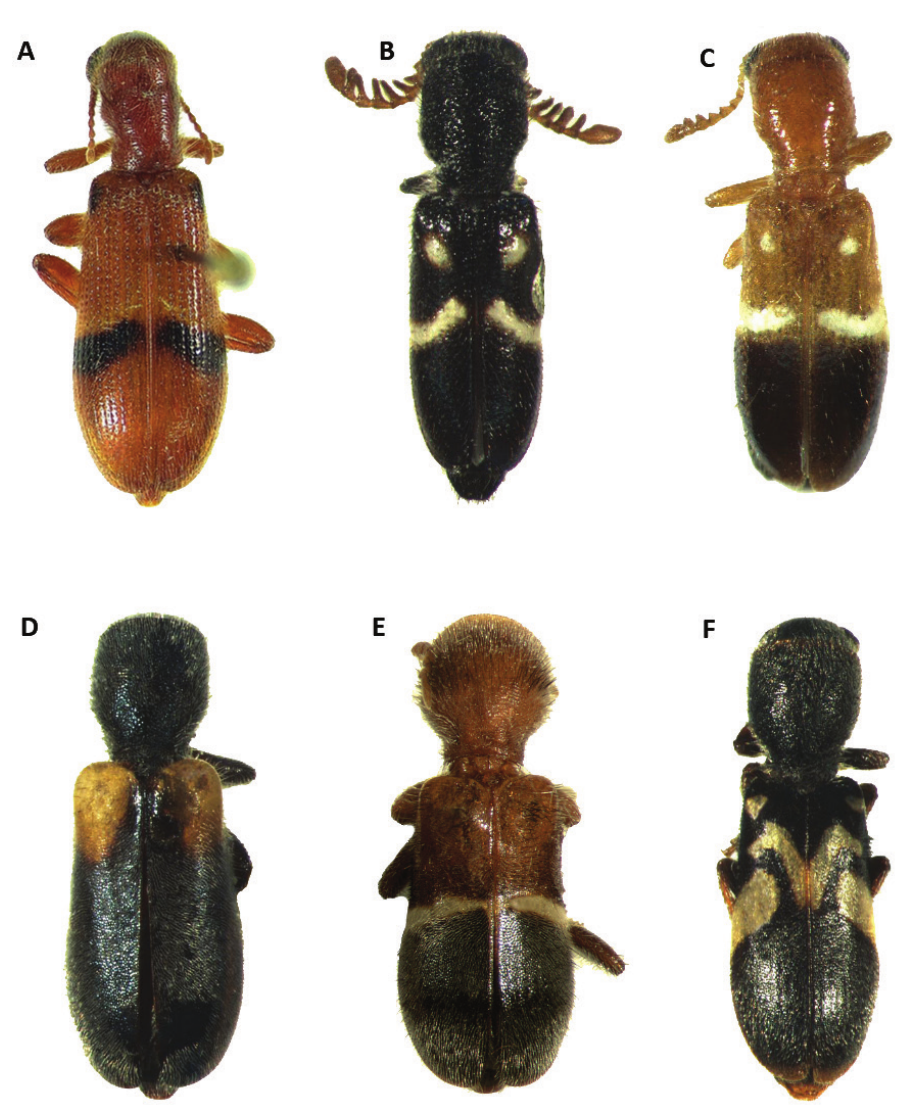
Figure 2. Habitus of: A Bogcia oaxacae syn. n. B Neocallotillus elegans (black morph) C Neocallotillus elegans (bi-colored morph) D Callotillus bahamensis E Callotillus eburneocinctus F Neocallotillus intricatus. Type locality. Mazatlán, Sinaloa, Mexico. Type depository: California Academy of Science